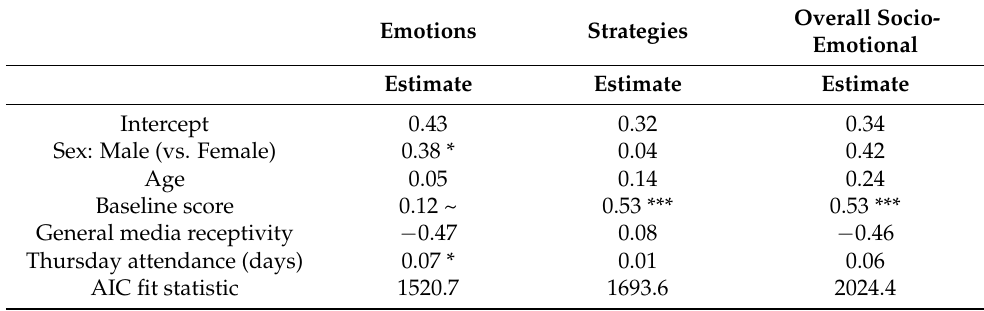
Table 5. The HLM models predicting the socio-emotional outcomes, exploring Thursday